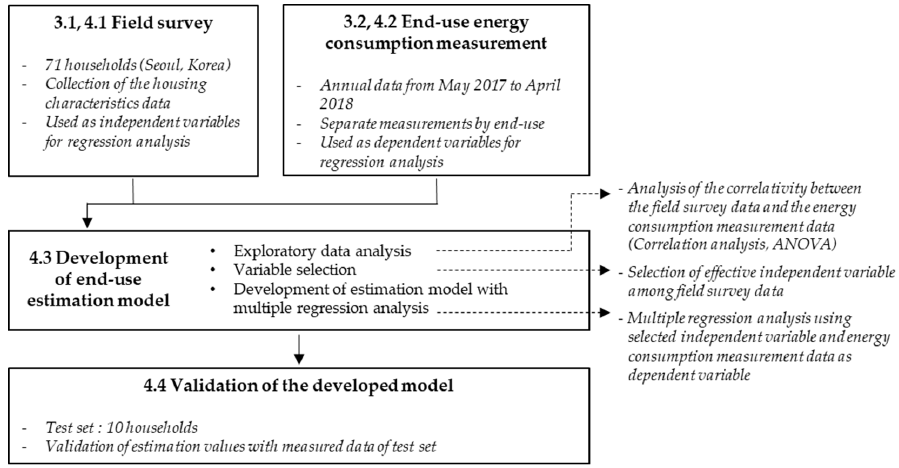
Figure 1. Research flowchart for the development of the regression model.